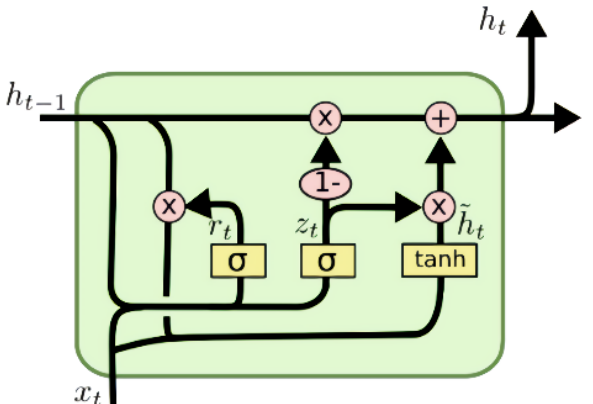
Figure 4. Illustration of the model based on using GRU for the tested GaN HEMT.